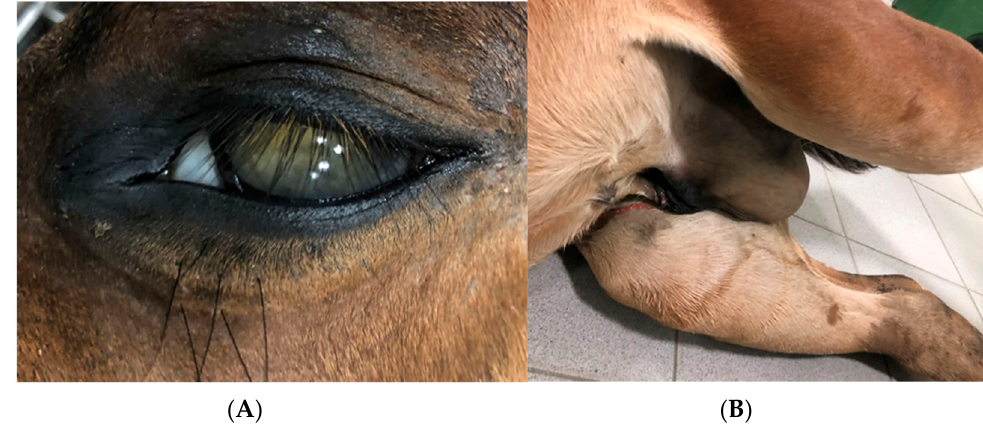
Figure 2. Anatomopathological findings concerning Case 2.1. Uveitis ( A ), scrotal edema and hernia ( B ).